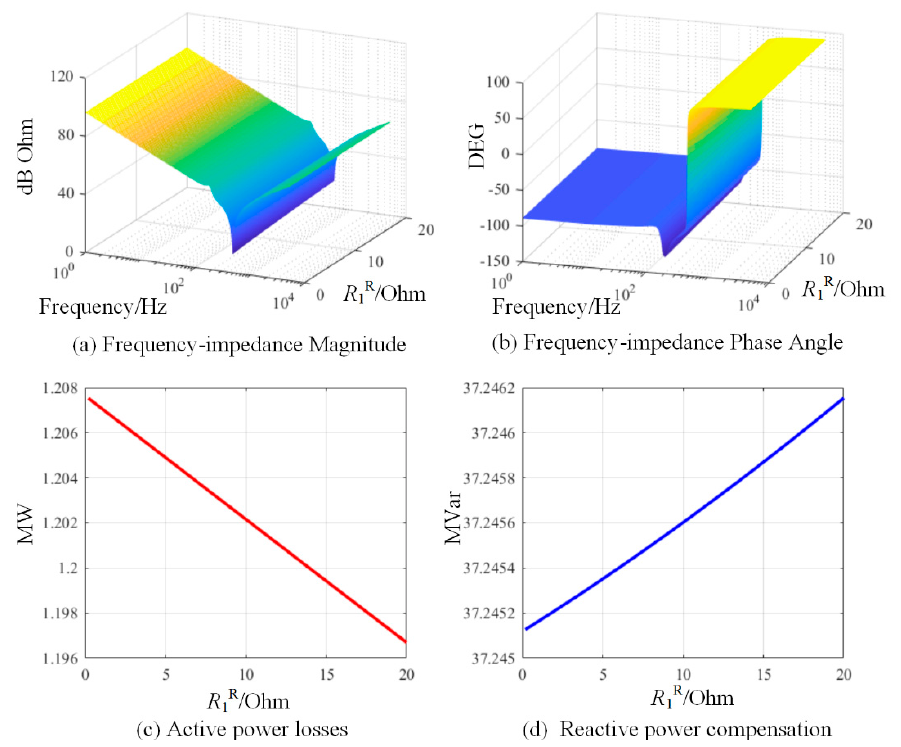
Figure 12. Resonant filter impedance, active power loss and reactive power compensation with different coil resistance.